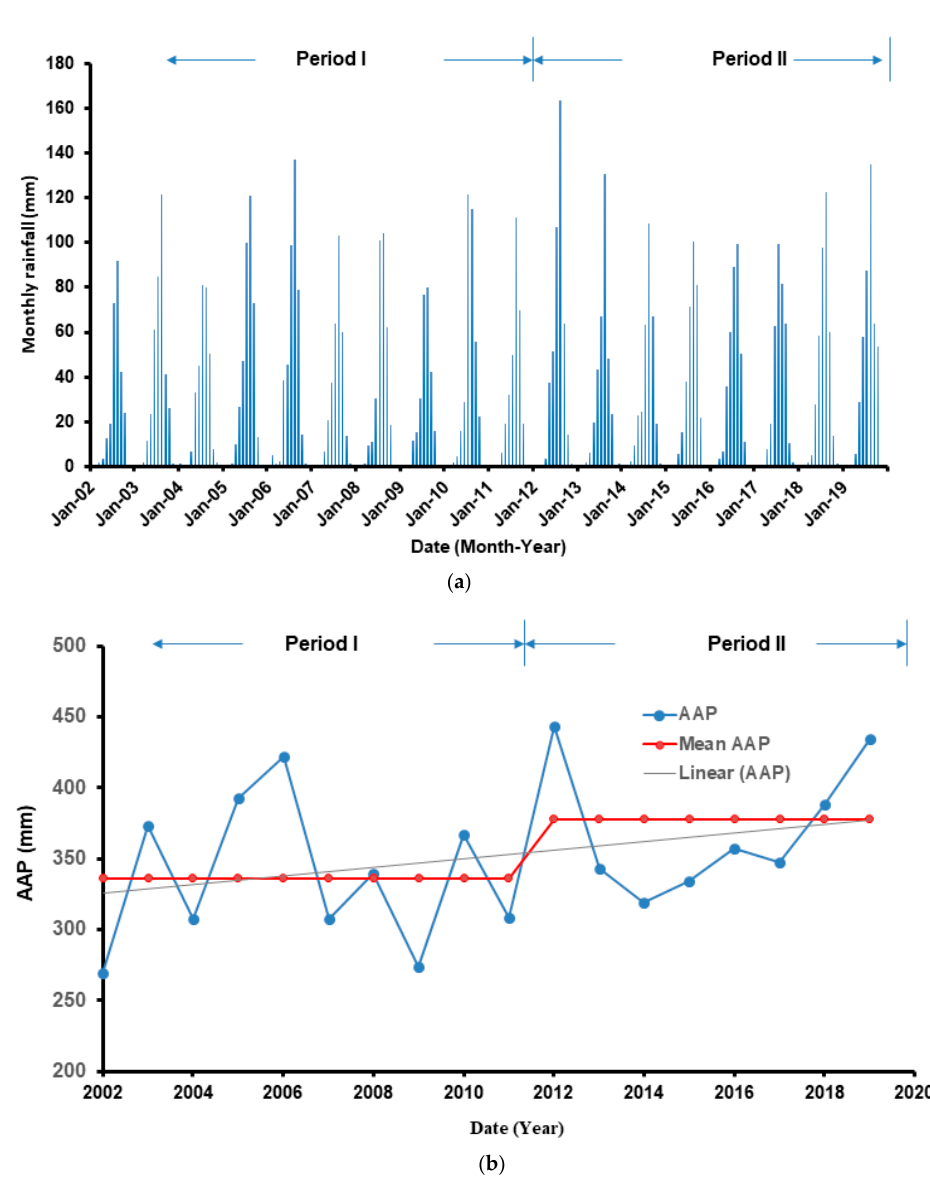
Figure 3. AAP (mm) was extracted from the TRMM data over the study